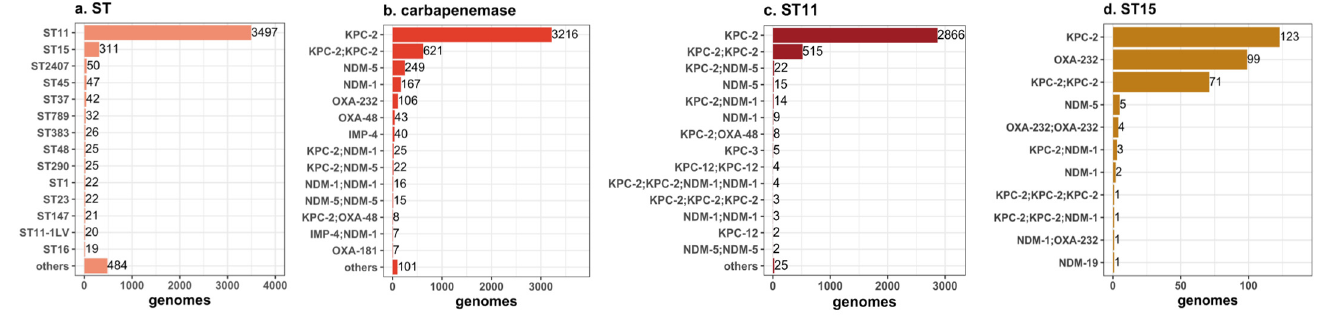
Figure 2. ST types ( a ) and carbapenemase types of KPN ( b – d ). KPC-2 had ST11 as the dominant clonotype (3384/3841, 88.1%), followed by ST15 (195/3841, 5.1%). OXA-232 had ST15 as the dominant clonotype (103/110, 93.6%), whereas OXA-48 had ST383 (25/43, 58.1%) and ST147 (8/43, 18.6%) as the dominant clonotypes. In